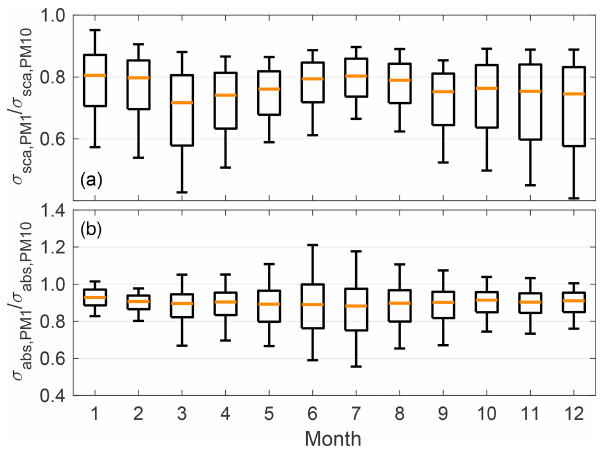
Figure 2. Seasonal variation in the PM 1 / PM 10 ratio for (a) σ sca and (b) σ abs . The explanation for the boxplots are the same as in Fig.